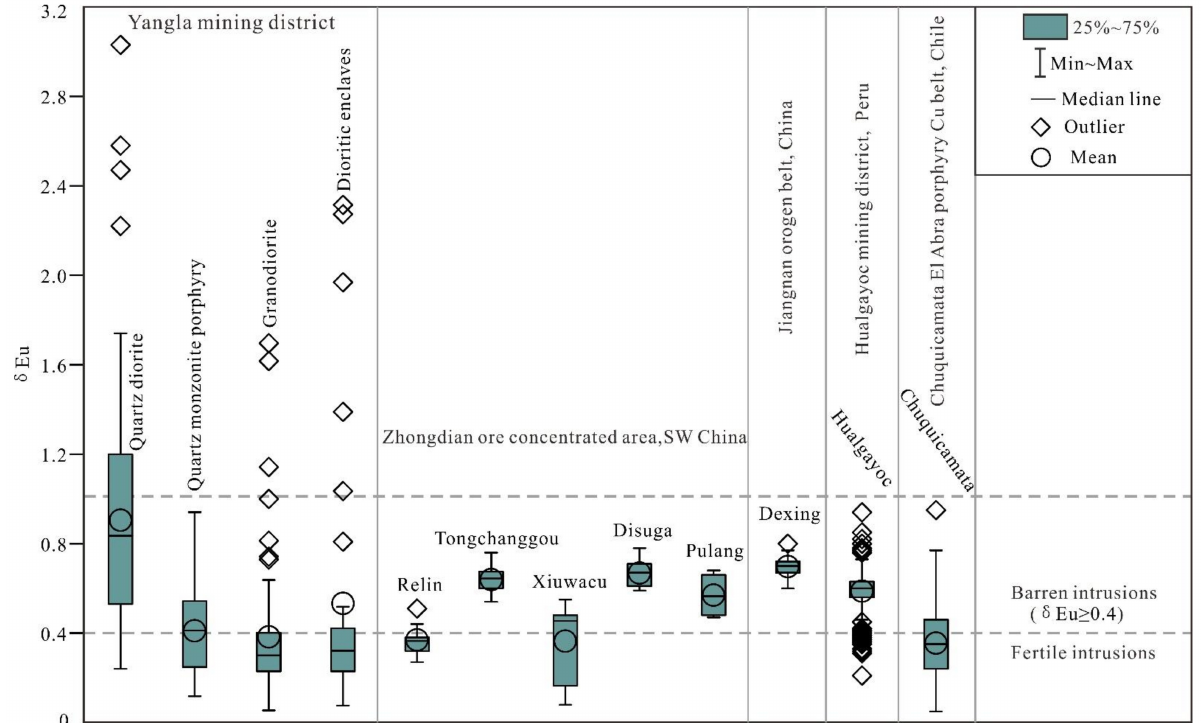
Figure 17. The zircon δ Eu values for Yangla granitoid plutons and other ore-related intrusions. Data for Yangla quartz monzonite porphyry, granodiorite, and dioritic enclaves from Meng et al. (2016) [3]; Data for Zhongdian ore concentrated area intrusions, SW China from Li et al. (2022) [67]; Data for Dexing porphyry Cu deposit intrusions from Zhang et al. (2017) [66]; Data for Hualgayoc mining district intrusions (Peru) from Viala and Hattori (2021) [49]; Data for Chuquicamata El Abra porphyry copper belt intrusions (Chile) from Ballard et al. (2002)